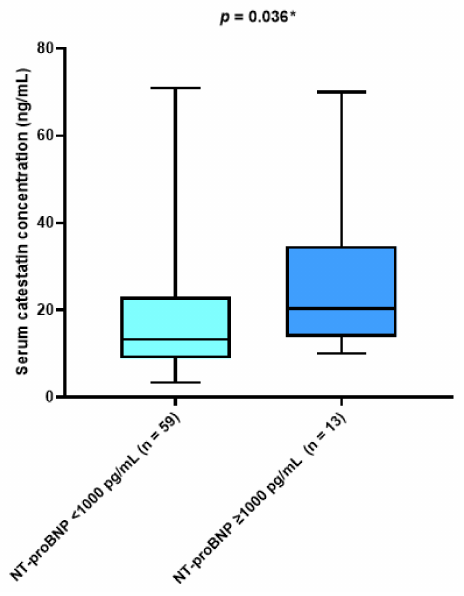
Figure 3. Comparison of serum catestatin concentrations with respect to NT-proBNP levels. Data are presented as median and interquartile range. * Mann–Whitney U test.